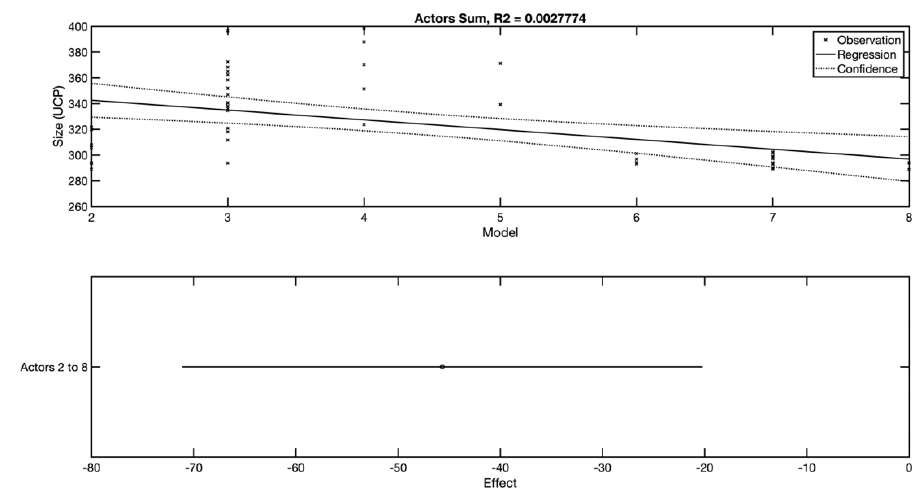
Figure 9. Total number of actors and the created model.